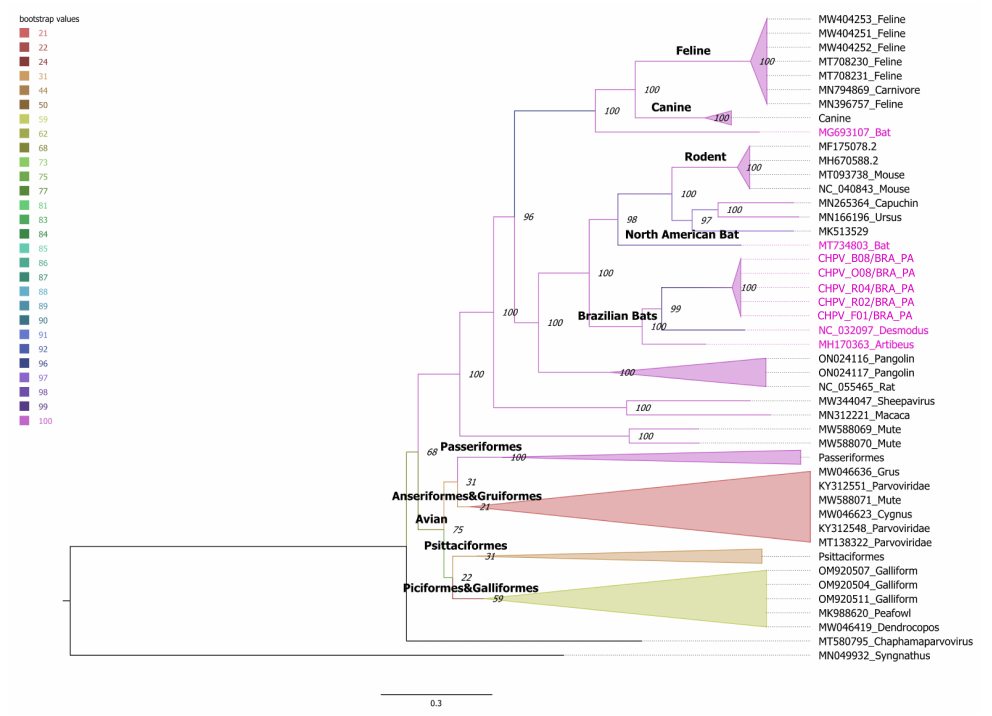
Figure 4. Maximum likelihood NS1 tree. Numbers above branches are bootstrap values. Sequences identified in bats are indicated by magenta color. The tree is unrooted and numbers in the nodes represent bootstrap values. Branches are colored according to the bootstrap support following color scale indicated in the figure. Horizontal line under the tree indicates the number of nucleotide substitutions per site. Clades in which CHPV was detected in the same category of host are indicated by names (Avian, Rodent, Bats, Feline and Canine). The tree was constructed using the GTR model plus gamma correction and the proportion of invariable sites was estimated. Bootstrap values were calculated using the ultra-fast approximation approach